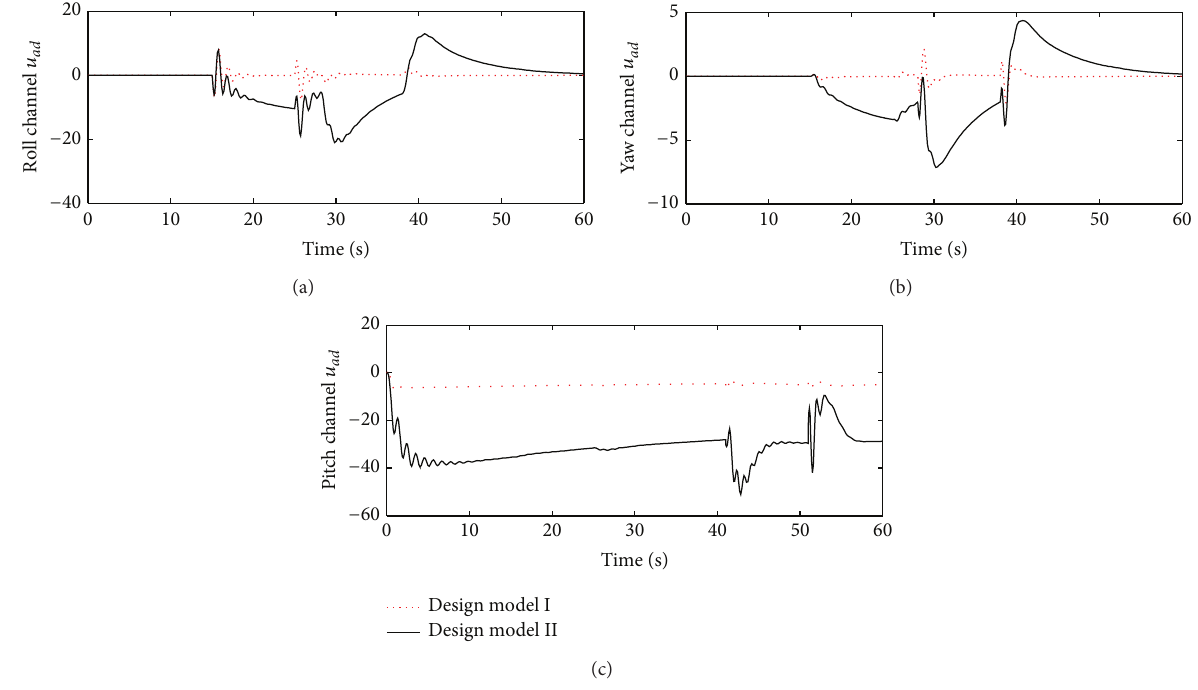
Figure 9: The outputs of neural network in three